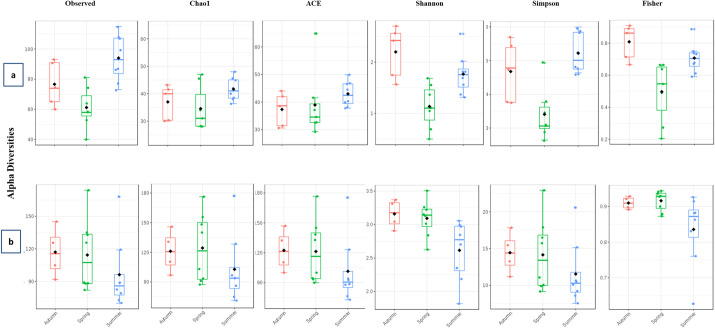
Season wise alpha diversity plots of (a) bacterial and (b) fungal communities. All comparisons were made through analysis of variance (ANOVA). Observed alpha diversity estimates are based on unique taxon richness or counts in each sample; Chao1 and ACE diversities are based on low abundance taxon richness; Shannon, Simpson and Fisher estimates are based on both taxon evenness (distribution) as well as richness.